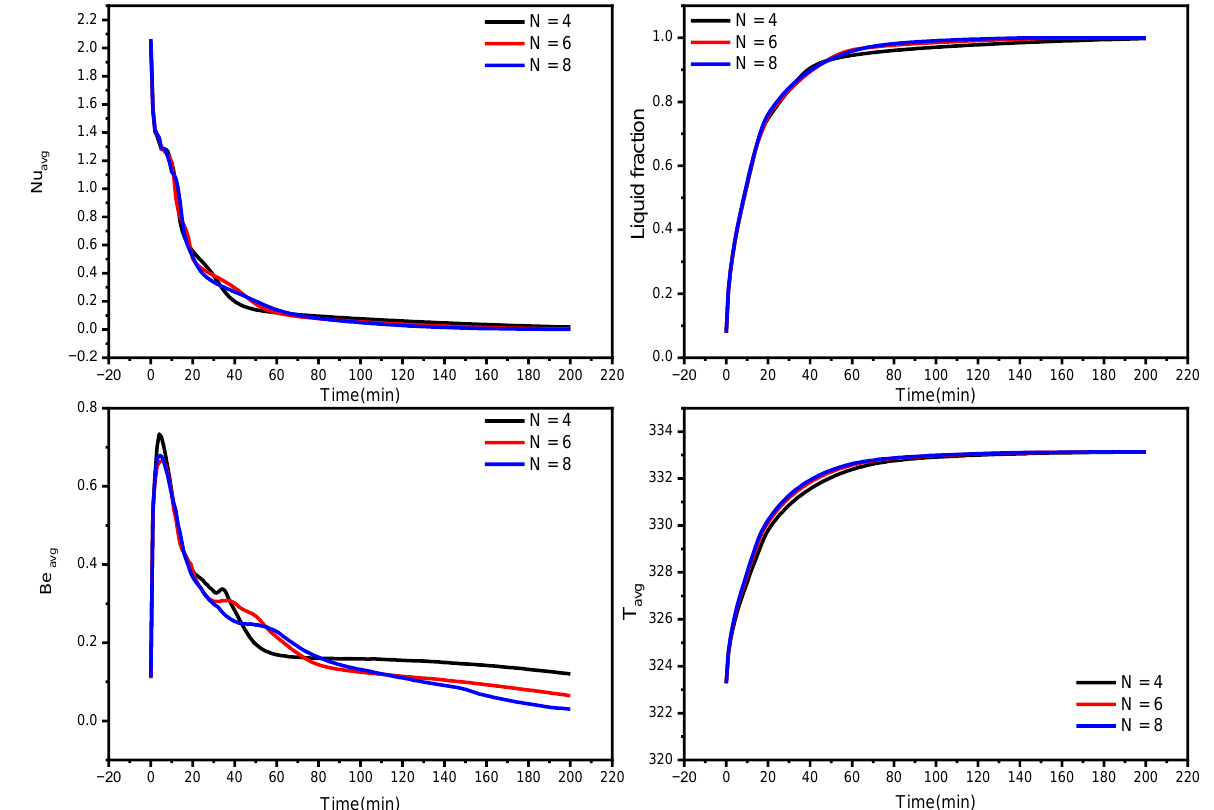
Figure 8. Influence of wave number on average Nusselt number, the average liquid fraction (B), Bejan number, and average temperature during the NePCM melting process.